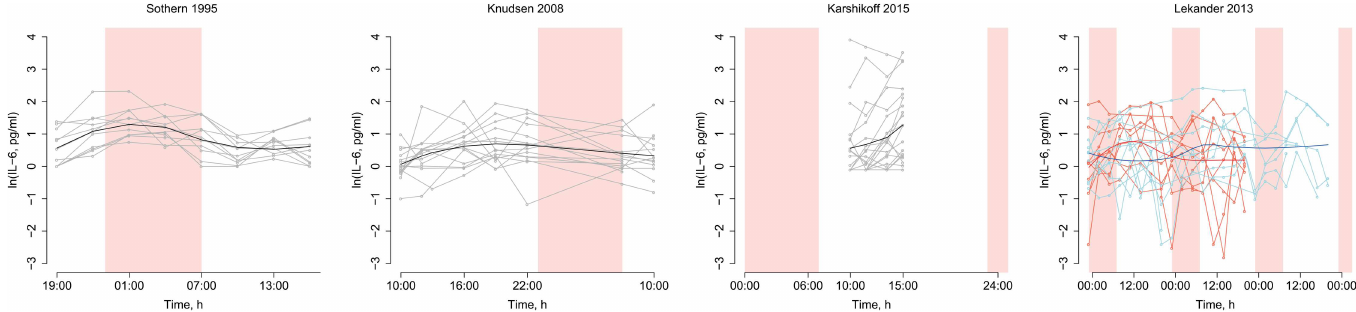
Fig 7. Individual participant data. Individual participantdata were availablefrom four datasets and are shown here mainly for the purposeof illustrating the high degreeof variabilitywithin individuals. To illustrate summary effects within each dataset, thick lines show loess functions fitted to each dataset. Time from 22:00 to 07:00 is shadedto indicate the night. For Lekander2013, two sets of measurements, made with a few days’ interval, have been plotted over the same time course, in red and blue